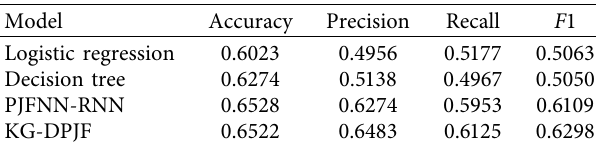
Table 7: The comparative experiment combined with structured data